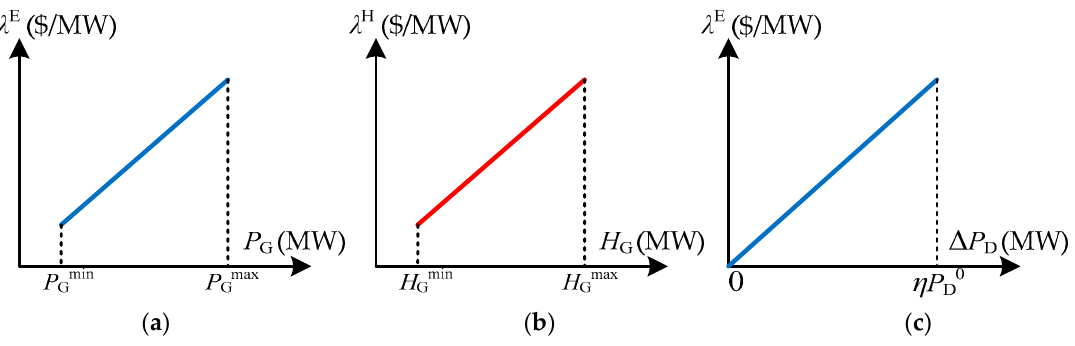
Figure 3. Incremental cost of various units. ( a ) Electrical incremental cost of diesel generator; ( b ) heat incremental cost of heat-only unit; ( c ) electrical incremental cost of energy consumer.